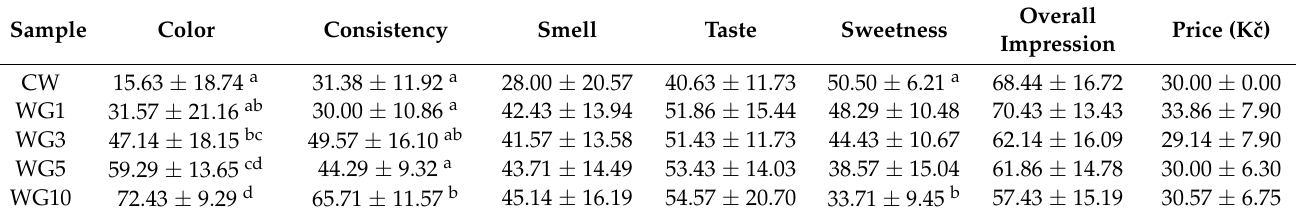
Table 3. Sensory Grades of Control Samples and of Samples with the Addition of Grape